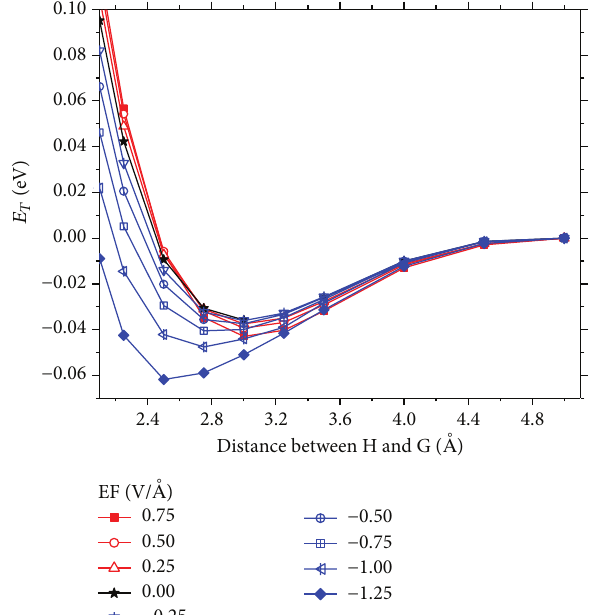
Figure 3: Total energy ( 𝐸 𝑇 ) versus distance between H and G, with some electric fields (EF) applied ( 𝐸 𝑇 = 0 eV for 𝑑 𝑝 > 5 ˚A).